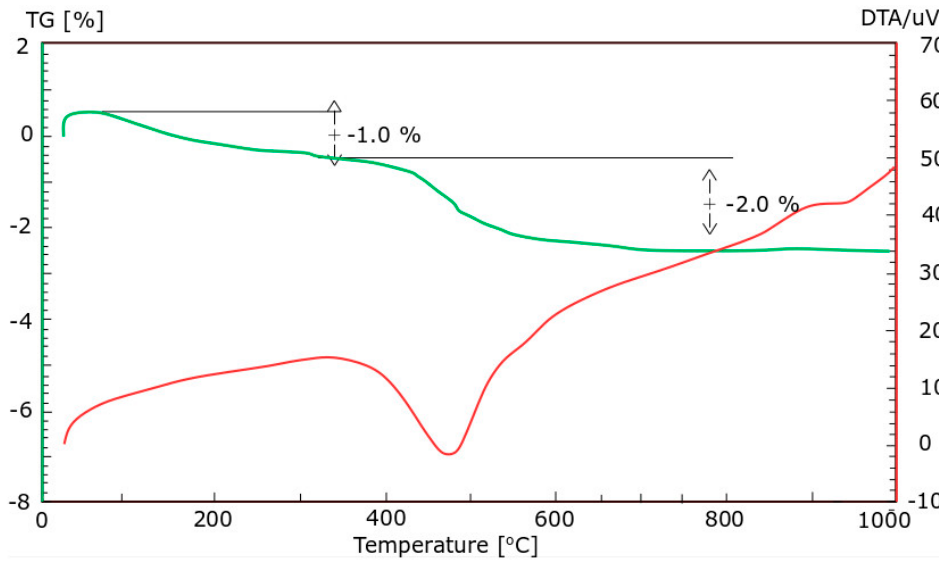
Figure 4. The differential thermal analysis (DTA) pattern of CFA batch C.